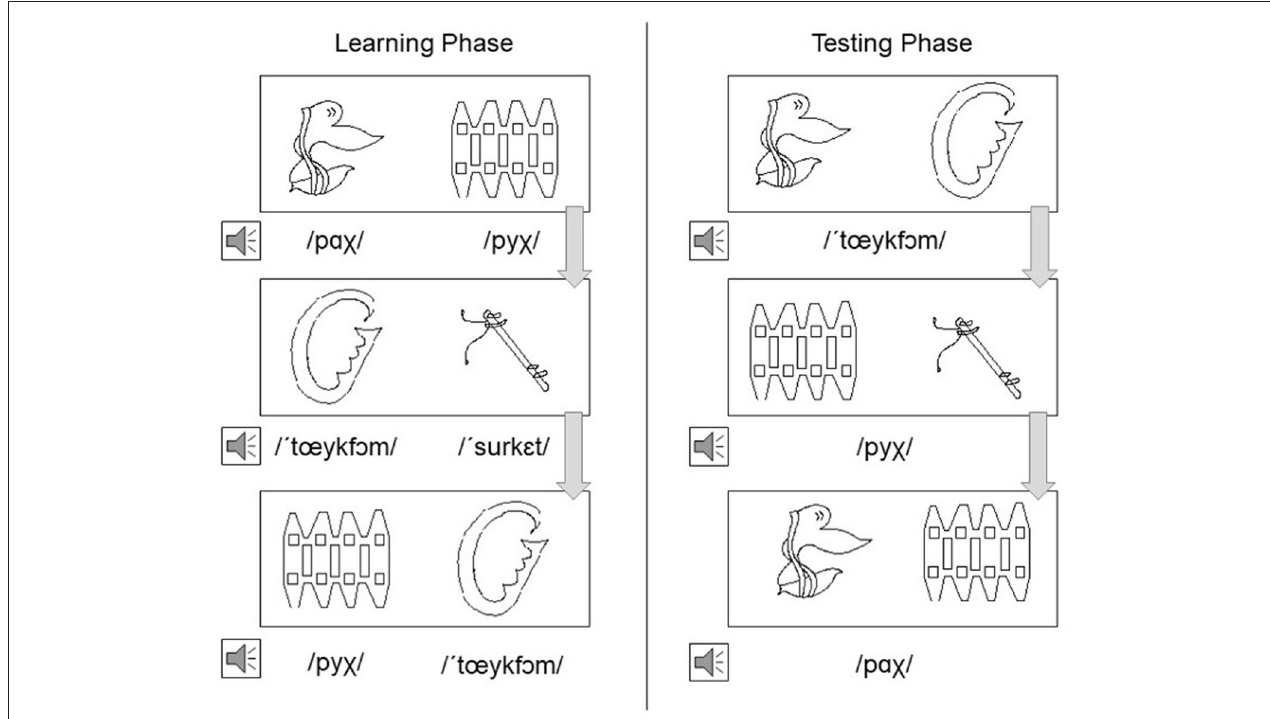
FIGURE 1 | Representation of Dutch learning phase and testing phase presented to participants. Arrows indicate linear order through trials; participants were first exposed to the learning phase and then the testing phase.